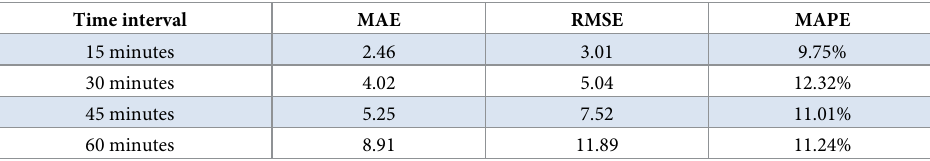
Table 3. Prediction performance for different time